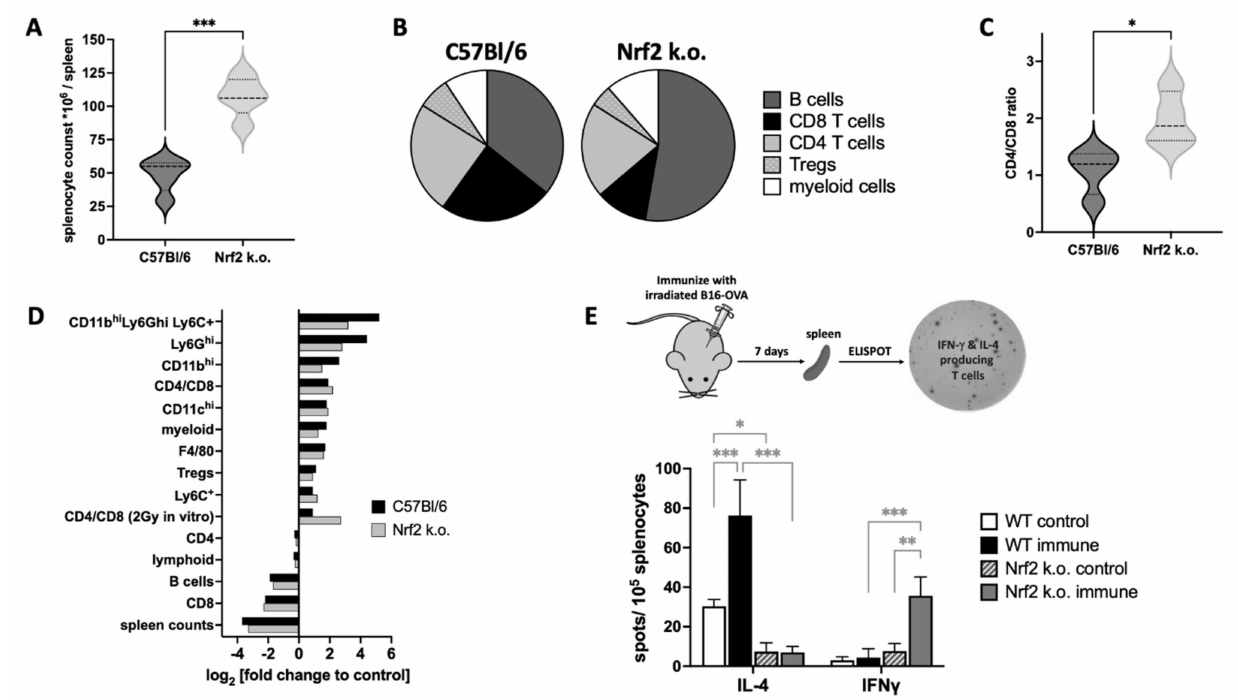
Figure 3. ( A ) Nrf2 k.o. mice had 2-fold more splenocytes than WT C57Bl/6 controls (data are the median and interquartile range of splenocyte counts of n = 5 spleens/strain). ( B ) Most of the increase in splenocytes in Nrf2 k.o. mice was due to a rise in B cells, with lesser increases in myeloid cells and decreases in CD8+ T cells and Tregs. ( C ) The decrease in CD8+ splenocytes were the main reason for increases in the median CD4:CD8 ratio ( n = 4). ( D ) Nrf2–/– CD8+ cells were more sensitive to 2 Gy in vitro irradiation than WT resulting in a greatly increased CD4:CD8 ratio, and spleens harvested 30 h after LD70/30 WBI had decreases in both CD8+ T cells and B cells while myeloid cells, especially more immature CD11b hi Ly6G + C + cells increased. Data are log2-fold changes (irradiated vs. control) in 10 5 cells from n = 3 pooled spleen/group. ( E ) A vaccine of 10 7 lethally irradiated (25 Gy) B16-OVA cells was injected i.p. into WT or Nrf2–/– mice and IL-4 and IFN- γ responses in splenocytes assayed by ELISPOT 7 days later. WT immune mice showed strong IL-4 responses while Nrf2 k.o. immune mice made strong IFN- γ responses, suggesting that NRF2 controls immune Th cell polarization. Data are mean ± s.d. of n = 3; repeated once. * p < 0.05, ** p < 0.01, *** p <